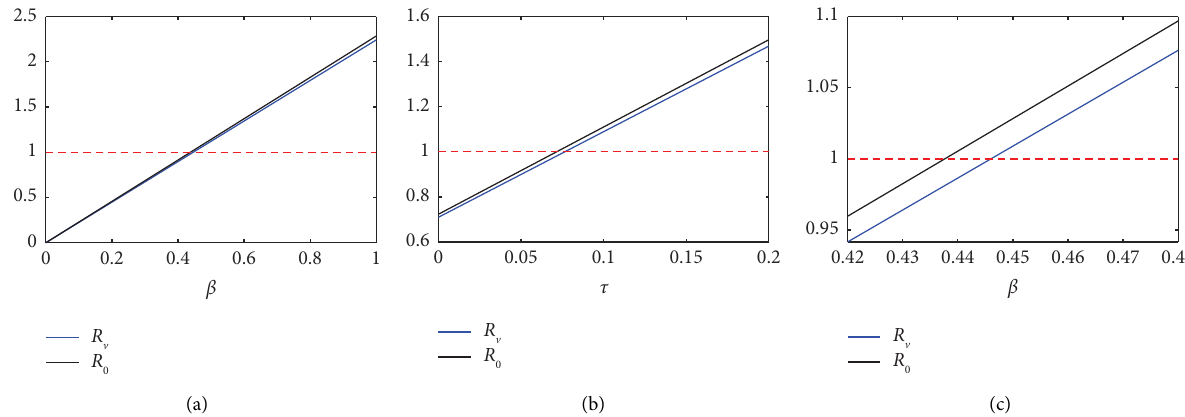
Figure 6: Variation of R v with respect to: the transmission rate β , (a) and infectivity factor of asymptomatic individuals τ , (b) (c) Shows the zoom plot of ( a ) . Te red doted line is used to mark the line at one. Other parameter values are given in Table